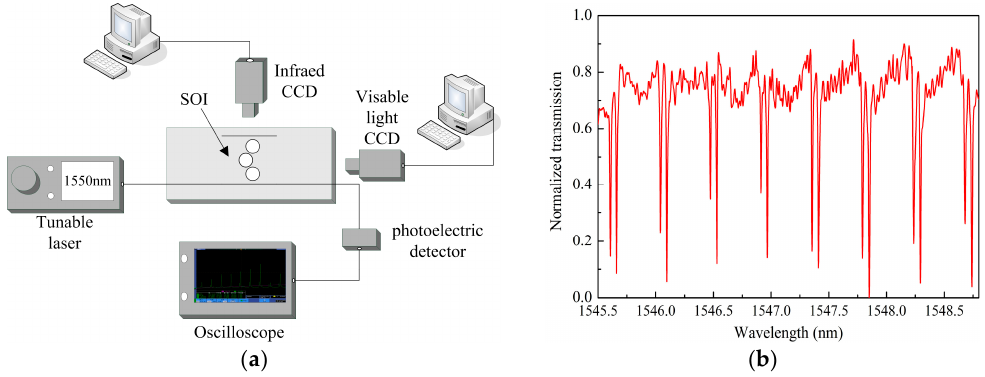
Figure 6. ( a ) Device measurement setup and ( b ) scanning curve of the structures with θ = 30°.